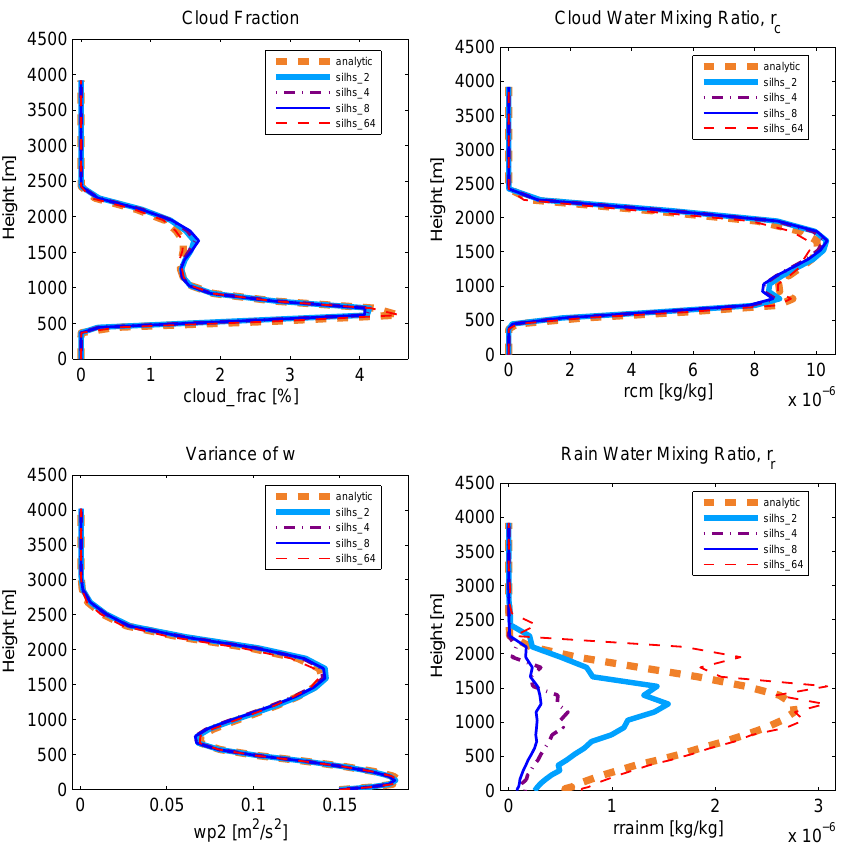
Fig. 3. Profiles of cloud fraction (upper left), cloud liquid mixing ratio (upper right), variance of vertical velocity (lower left), and rain mixing ratio (lower right) from the RICO shallow cumulus simulation. Five different integrations of the microphysics are overplotted: analytic (orange dashed line), and SILHS-based sampling with 2 points (light blue solid line), 4 points (purple dot-dashed line), 8 points (dark blue solid line), and 64 points (red dashed line) per grid box and time step. Profiles are averaged over the last 12h of the simulation. Averaged over 12h, the noise manifested in the time series (Fig. 1) is significantly smoothed, except in rain mixing ratio itself.